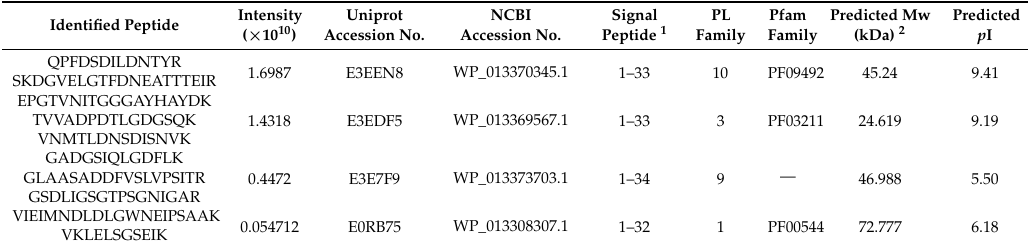
1 Signal peptides were predicted using the SignalP 4.1 server (http://www.cbs.dtu.dk/services/SignalP/) [25]. 2 Molecular weight and p I were predicted using the ExPASy Compute p I/Mw tool